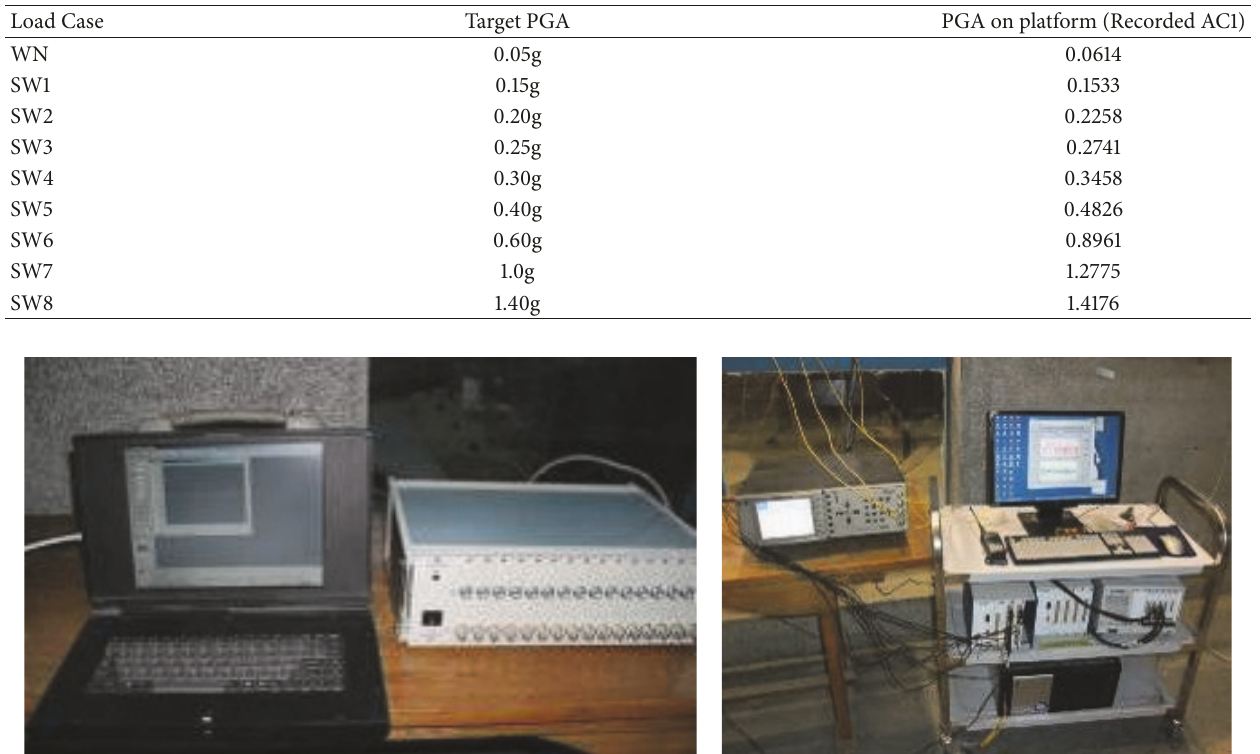
Table 6: A series of seismic inputs.